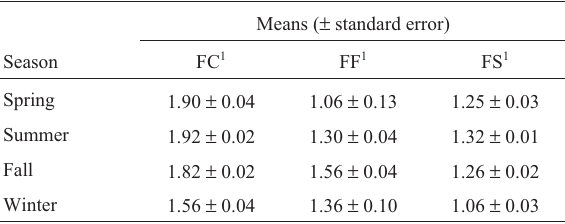
Table 5 - Variance components, heritability, and repeatability of number of flies counted on animals (FC), number of flies in photographs (FF), and infestation score (FS), obtained by the one-trait